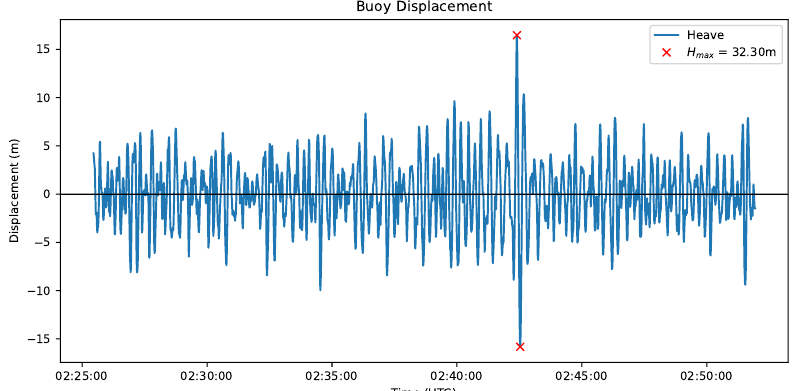
Figure 4. Time series of Datawell heave for sample period (30 min) in which the rogue wave was measured. The maximum crest and trough are indicated.